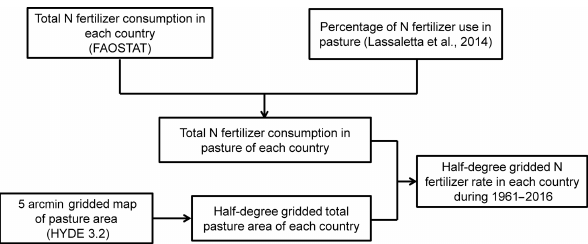
Figure 1. Diagram of the workflow for developing the database of global annual N fertilizer use rate in pasture during the period